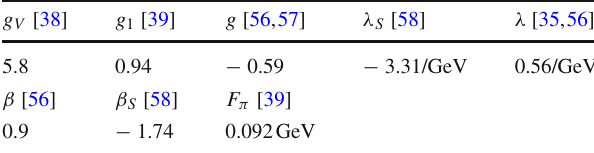
Table 3 The coupling constants adopted in the calculations